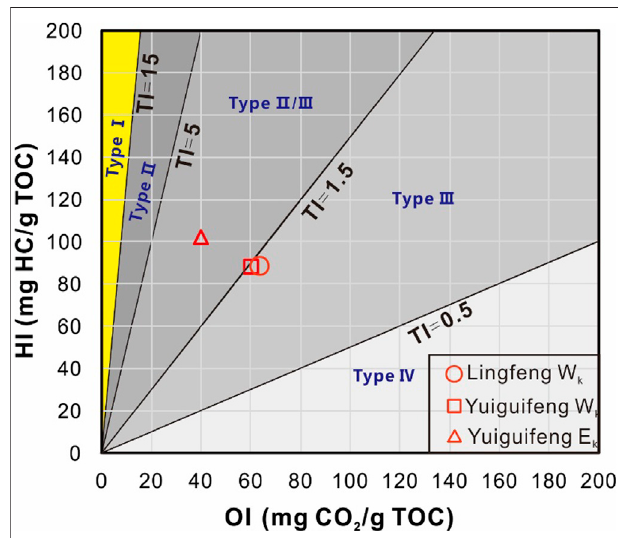
FIGURE 8 | Classi fi cation chart of kerogen types (modi fi ed after Van Krevelen, 1993; Peters et al.,